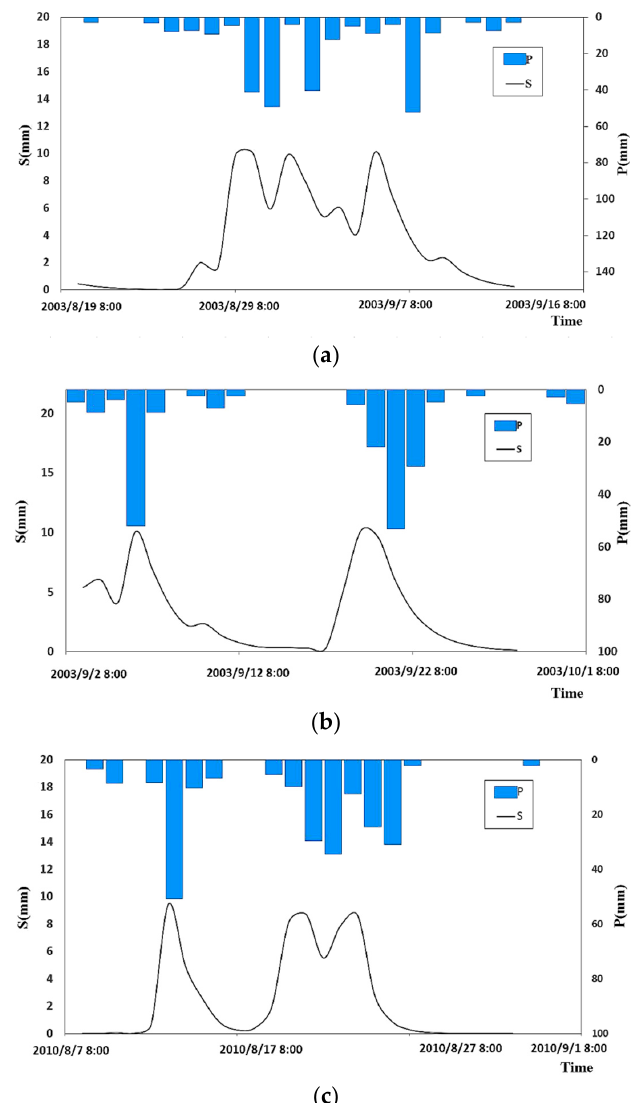
Figure 5. Hydrologic simulations showing the change process of free water storage and rainfall for the Chenhe watershed: ( a ) 19 August–12 September 2003; ( b ) 2–26 September 2003; ( c ) 6–30 July 2010.